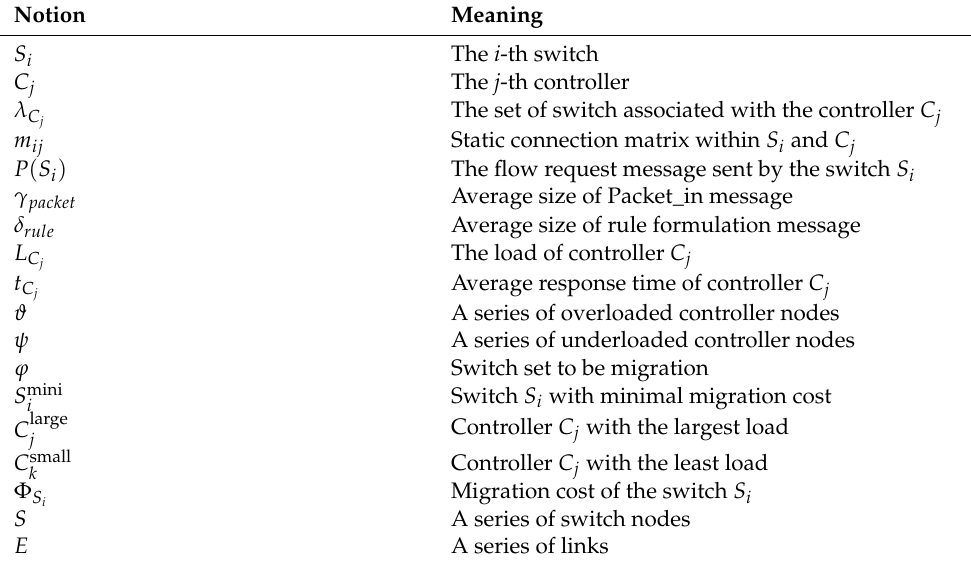
Table 1. Notations in this